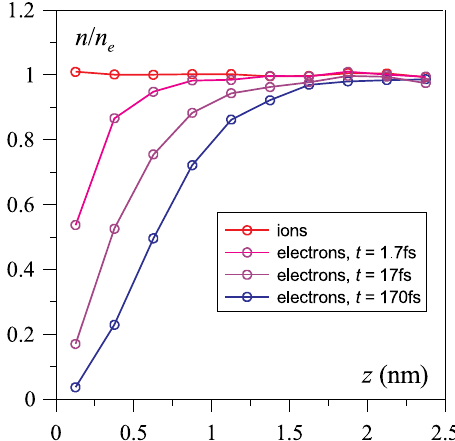
FIG. 5. Development of the electron density profile with time. The time moments are shown in the legend. The density is normalized by the mean density in the initial state; n e ¼ 10 23 m (cid:1) 3 , T ¼ 1 eV